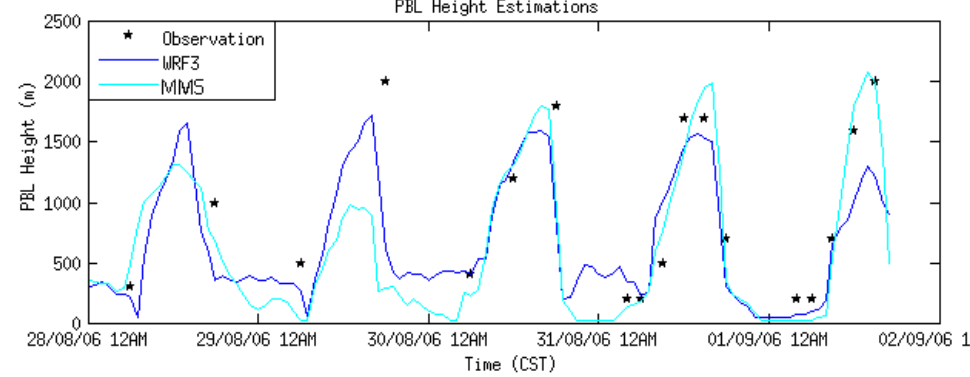
Figure 7. Comparison of observed and simulated PBL height for the study period. The WRF simulation tended to underestimate more than either of the MM5